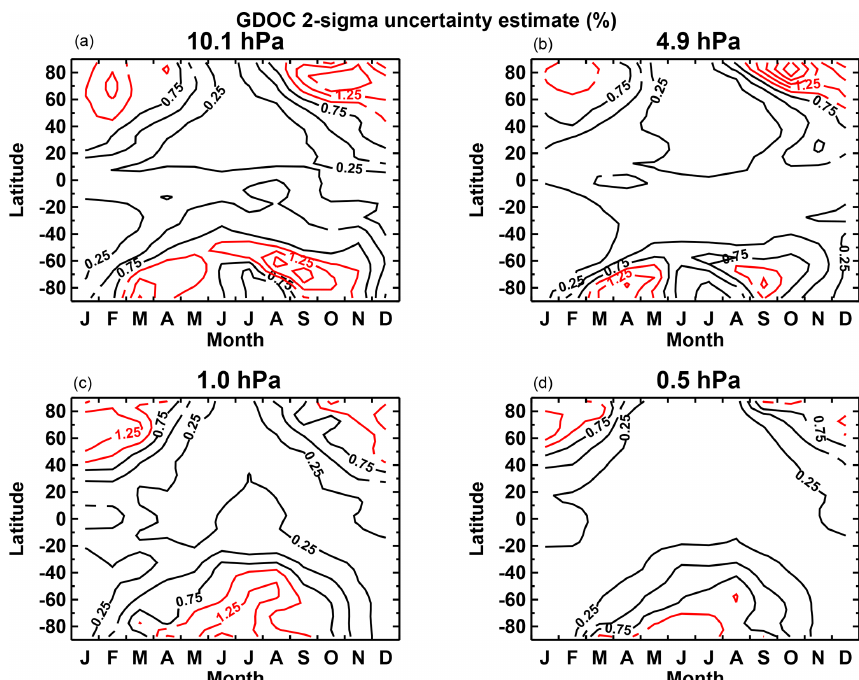
Figure 3. GDOC uncertainty estimates at noon local solar time, plotted as a function of month and latitude at four pressure levels: 10.1hPa (a) , 4.9hPa (b) , 1.0hPa (c) and 0.5hPa (d) . The uncertainty is defined as the SEM in each bin, which is computed assuming 720 independent data points per bin. Contours of 1% and greater are highlighted in